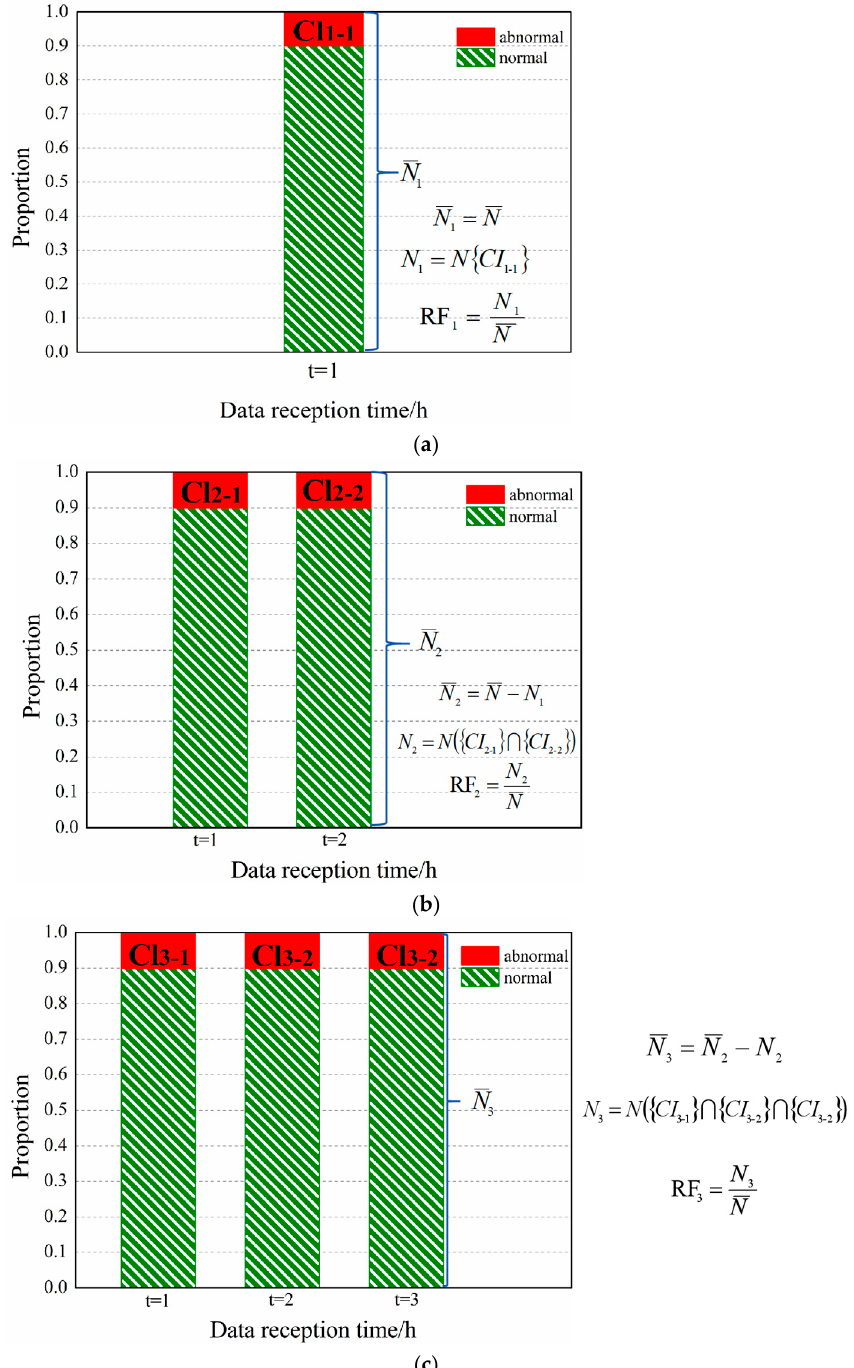
Figure 5. Schematic diagram of estimation of a set of thresholds required for a complete scan when STWL = 3, CRF = 30%: ( a ) first scan; ( b ) second scan; ( c ) third scan. STWL = 3, CRF = 30%: ( a ) first scan; ( b ) second scan; ( c ) third